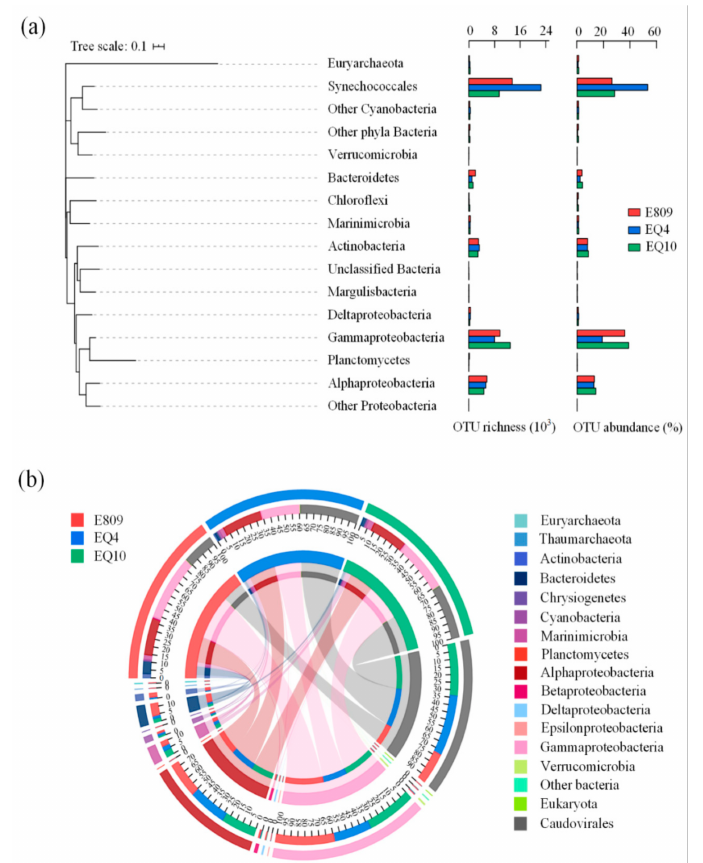
Figure 2. Taxonomic analysis and the number of detected taxa. A phylum-level (class-level for Proteobacteria) breakdown of relative abundances is shown for all samples, along with the number of detected taxa at the OTU level ( a ), bar graphs represent richness and abundance (%) of OTUs from three samples. The circos map shows different microbes contributes to the community based on microbe metagenome data ( b ), the outer semicircle above represents three samples, and inner semicircle marked scales represents the relative proportions of different microbes in the